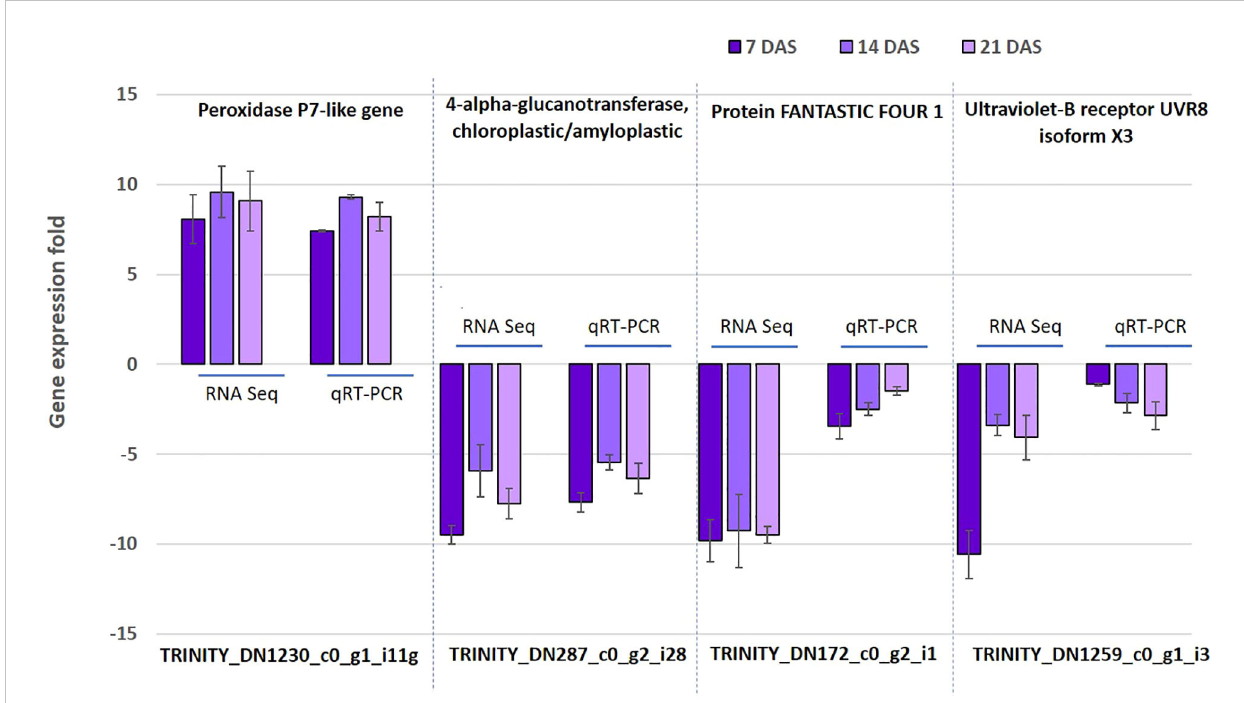
FIGURE 6 Validation of RNAseq data using quantitative real-time PCR. The expression of four selected genes was studied using qRT-PCR. Data are mean (SE) expressions from three biological replicates of sugar maple at each drought stress time. The b -tubulin and actin gene were used as an internal control for normalizing gene expression and fold change was calculated over the